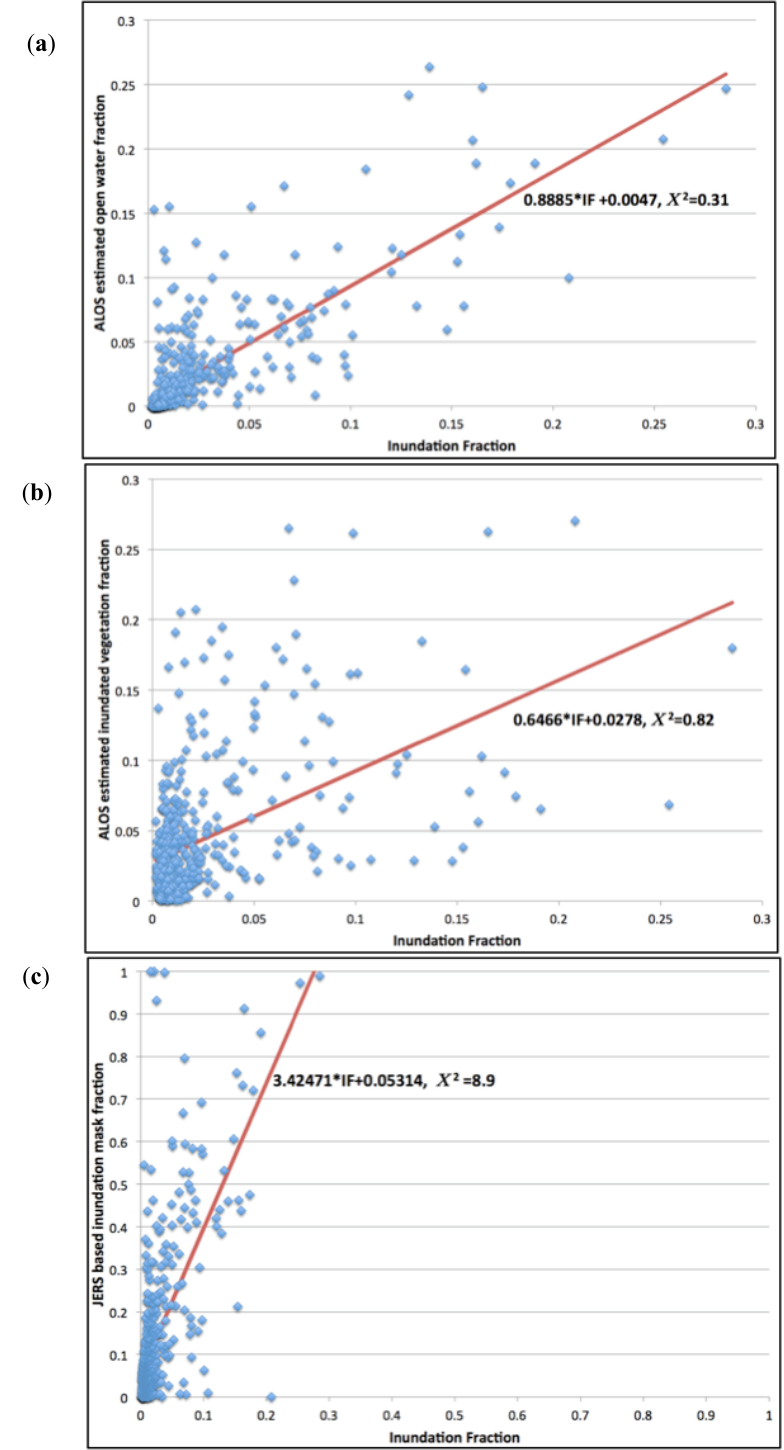
Figure 16. Comparison of ALOS and JERS-1 products with coarse-resolution surface water fraction. ( a ) ALOS open water fraction; ( b ) ALOS inundated vegetation fraction; ( c ) JERS-1-based mask (where there is overlap) versus the coarse resolution surface water fraction. Note that the scale of (c) is much larger. Only the ALOS open water fraction has a significant relation to the coarse resolution surface water fraction